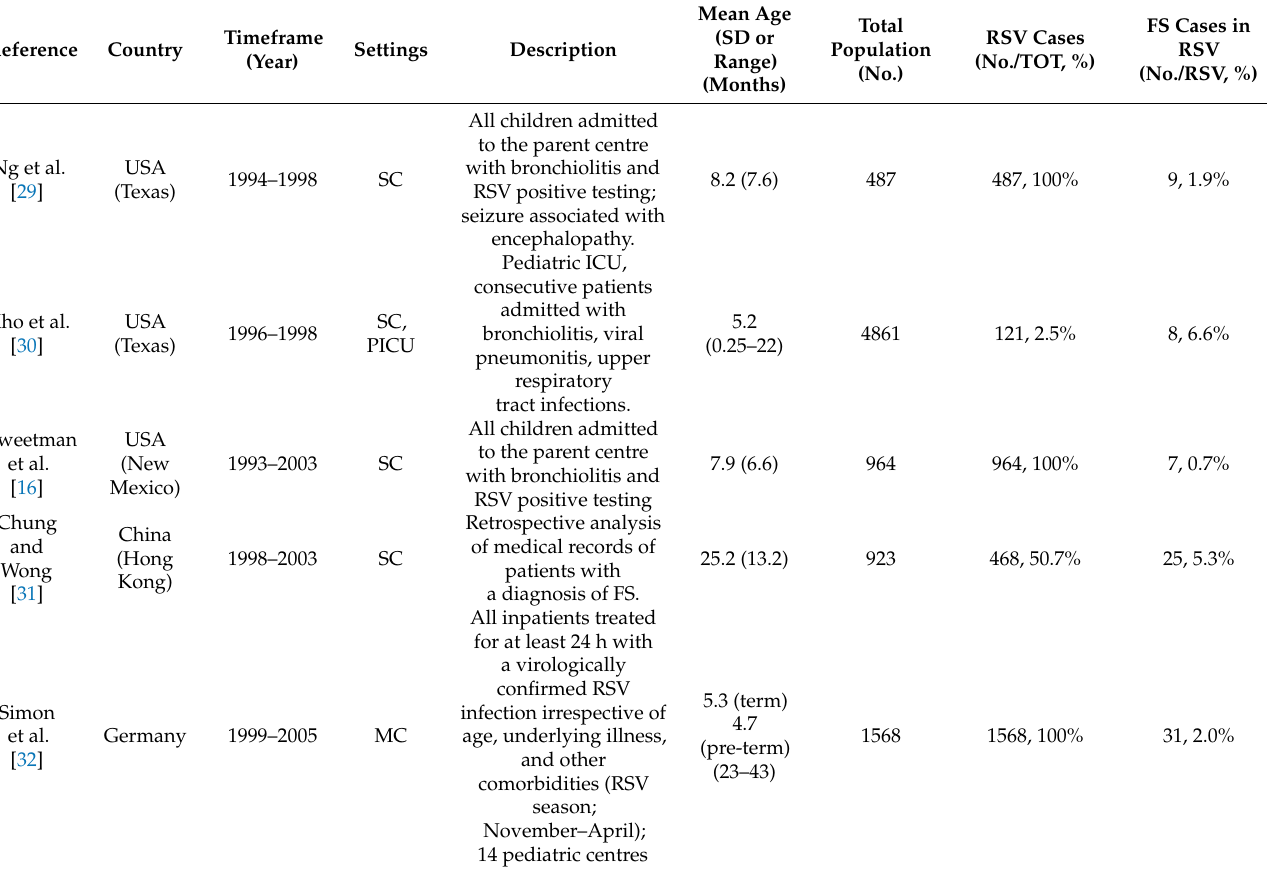
Table 2. Summary of included studies.